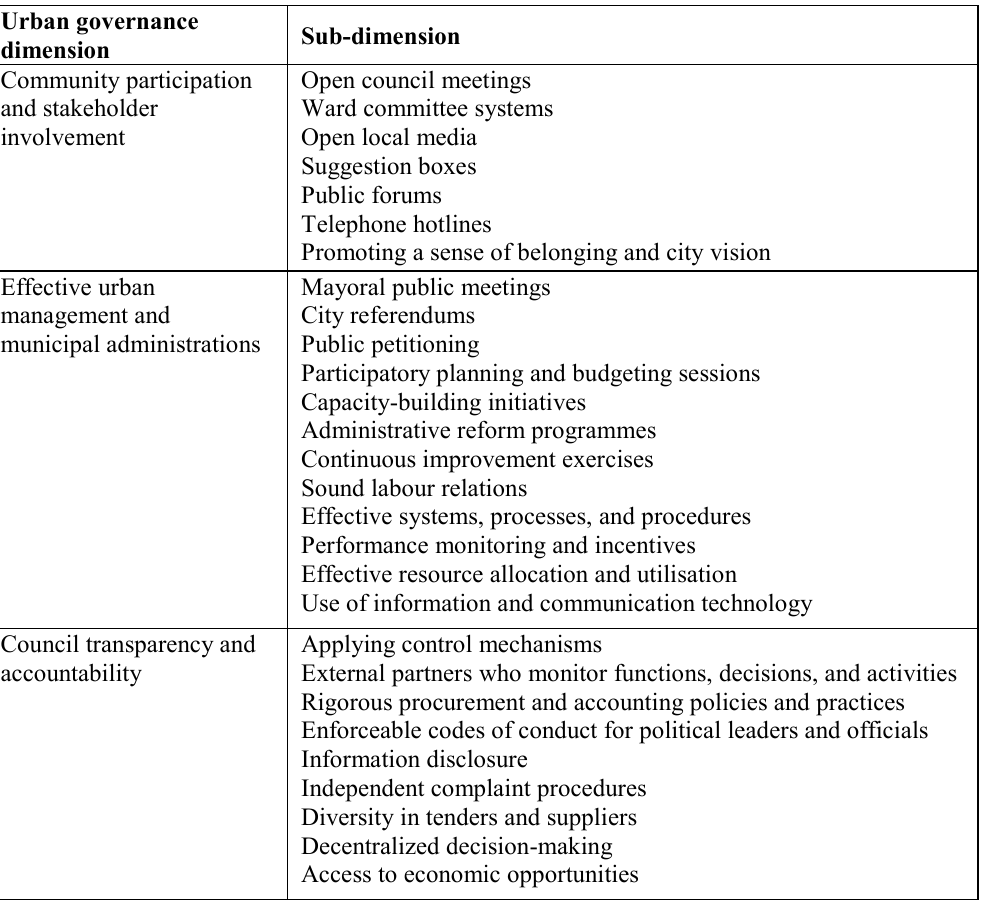
Table 1. Instruments and Tools for Urban Governance (Meyer & Auriacombe,